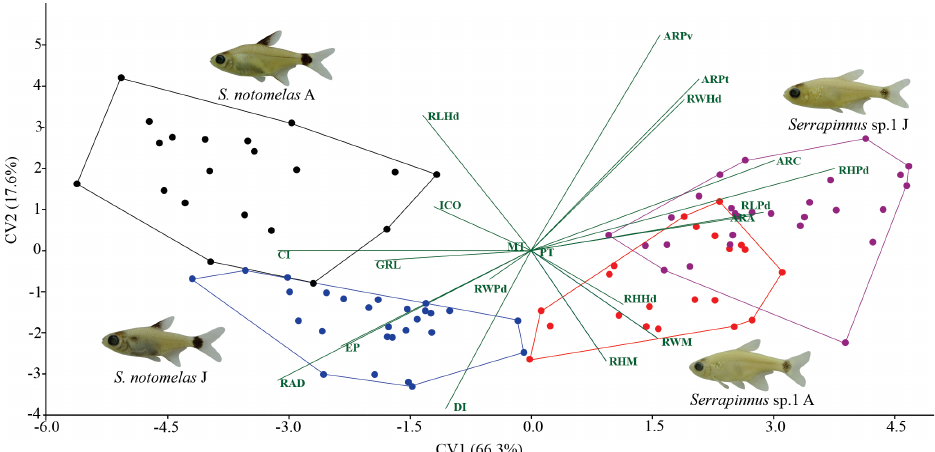
FIGURE 4 | Canonical variate analysis illustrating differences in morphological traits for the Serrapinnus notomelas and Serrapinnus sp.1 in a lake in the upper Paraná River floodplain, Brazil. CI – Compression index; DI – Depression index; RLPd – Relative lenght of caudal peduncule; RHPd – Relative height of caudal peduncule; RWPd –Relative width of caudal peduncule; RAD – Relative area of dorsal fin; ARC – Aspect ratio of caudal fin; ARA – Aspect ratio of anal fin; ARPt – Aspect ratio of pectoral fin; ARPv – Aspect ratio of pelvic fin; RLHd – Relative length of head; RHHd – Relative height of head; RWHd – Relative width of head; RHM – Relative height of mouth; RWM – Relative width of mouth; EP – Relative position of eye; MT – multicuspid teeth; PT – pentacuspid teeth; ICO – Intestinal coefficient; GRL – Gill raker length.